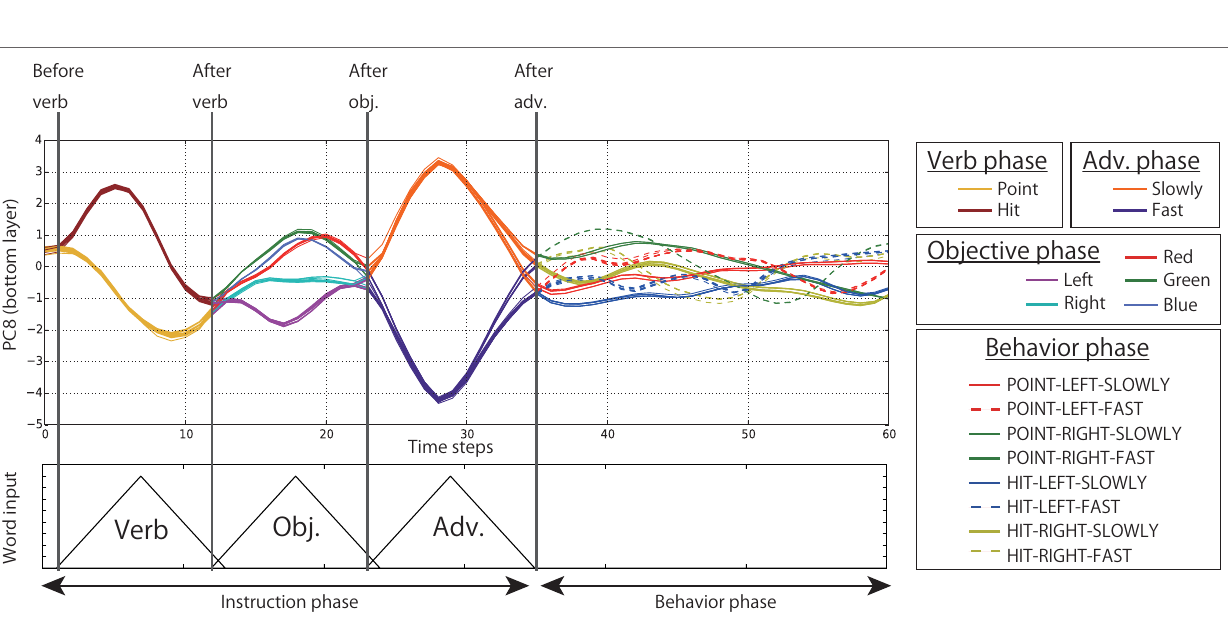
FIGURE 12 | The time development of the internal states in the bottom layer in the PC8 direction (CR is 3.0%) . Each line indicates the time development during one episode. The lines are colored differently in verb, objective, adverb, and behavior phases. This figure shows that the internal states of the bottom layer are activated in accordance with the current I/O flows, and past information quickly vanishes from the